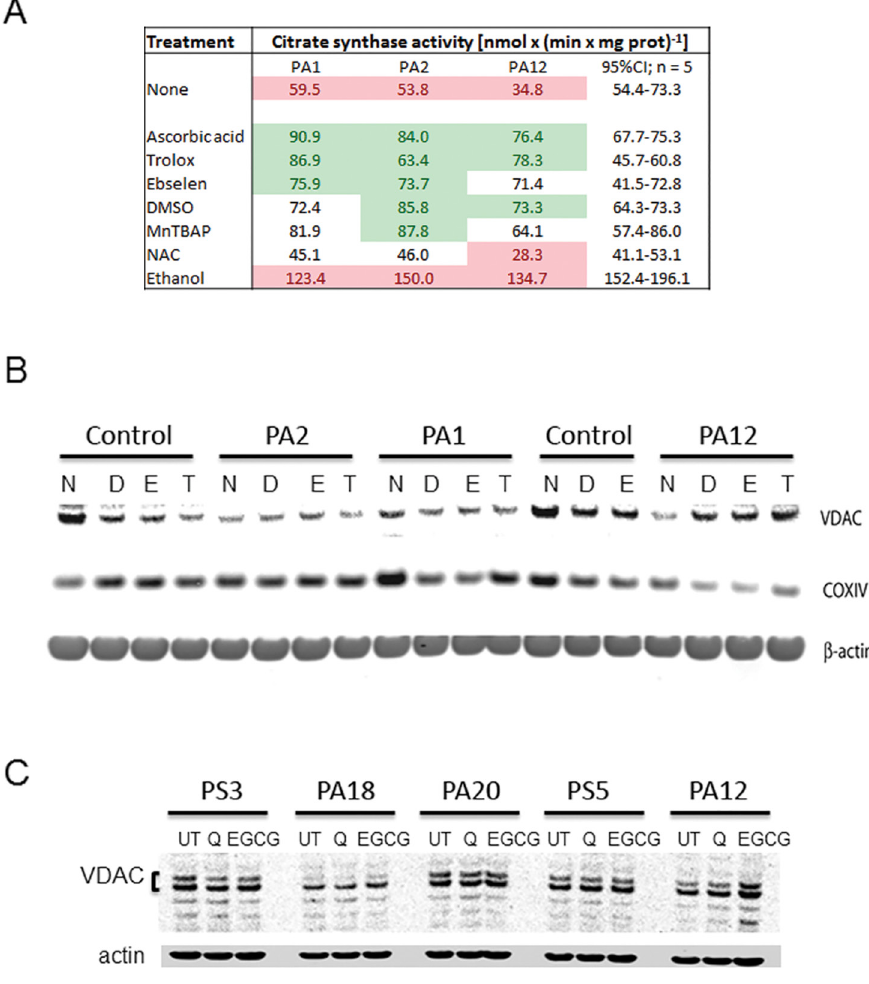
Figure 3. Effect of antioxidant treatment on the recovery of mitochondrial biomarkers. (A) Citrate synthase activity (expressed as nmol × (min × mg protein) −1 ) was evaluated in untreated (media only), vehicle-treated (DMSO), and antioxidant-treated cells ( n = 5 and n = 3, for controls and premutation, respectively; see Table 1) after 48 h. The 95%